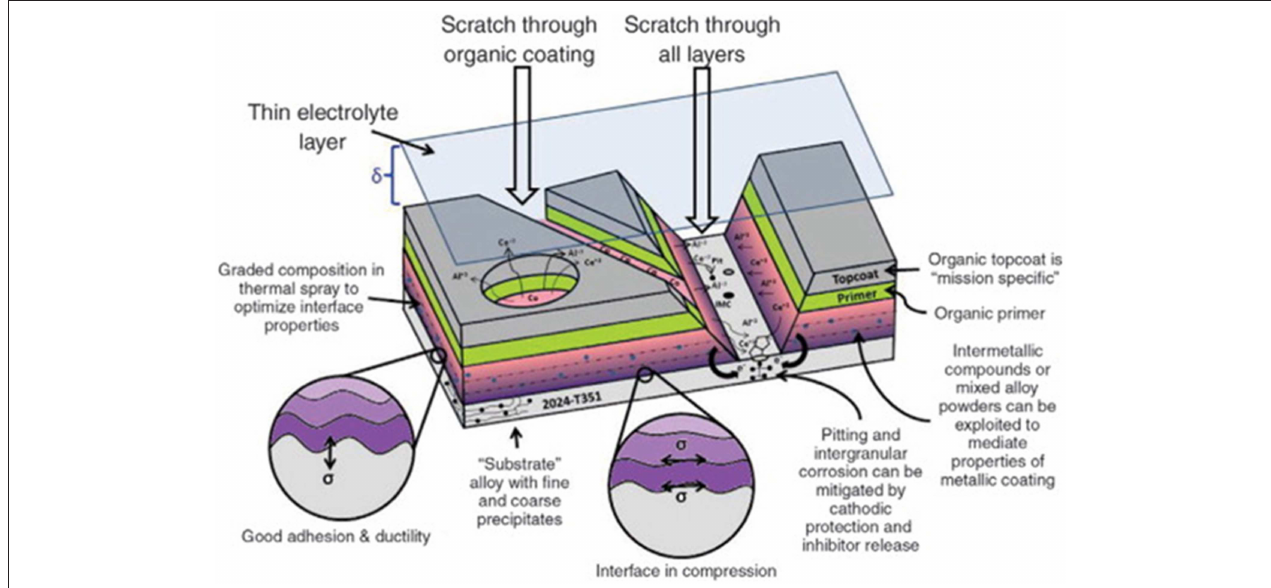
FIGURE 7 | Schematic of a full coating stack-up under atmospheric thin-film exposure (King and Scully, 2011). Various aspects of coating design are highlighted considering protection criteria, adhesion, barrier impedance, galvanic protection, throwing power, and inhibitor release. Reproduced with